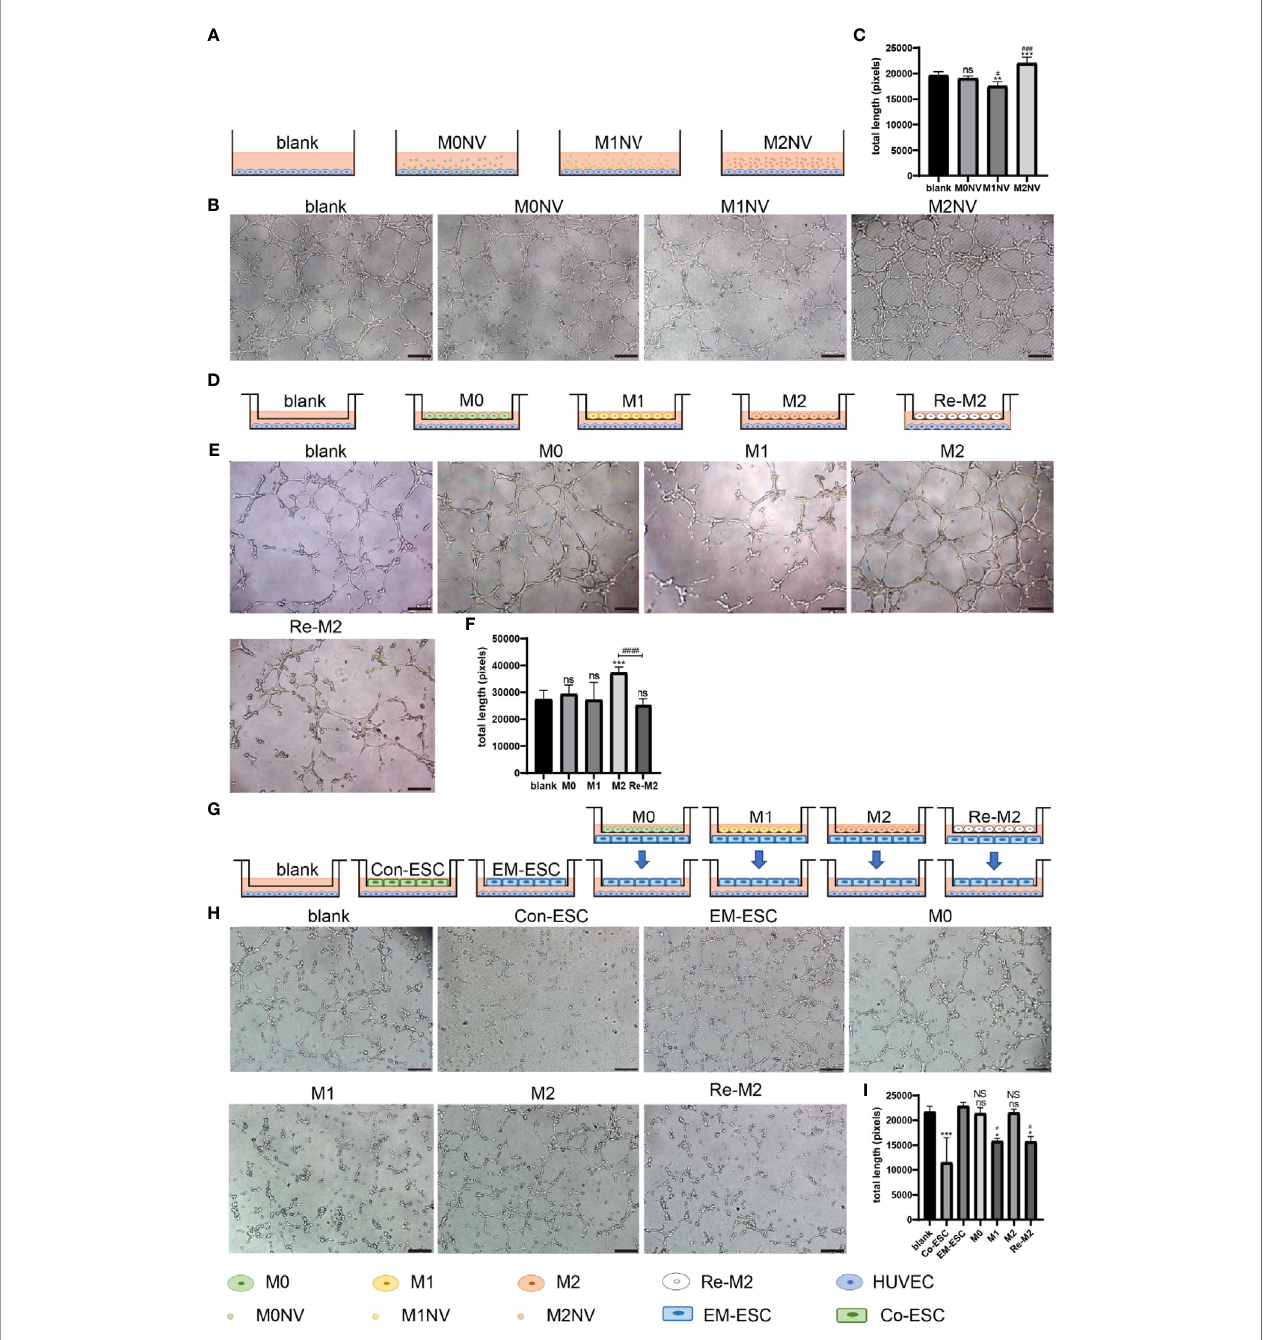
FIGURE 4 | M1NVs could inhibit HUVEC tube formation in vitro in direct and indirect way. (A, D, G) Co-culture pattern diagram of HUVEC tube formation. (B, C) Tube formation of HUVECs treated with NVs directly (Scale bar =100 m m). (ns: no signi fi cance when compared with blank. **P<0.01, ***P<0.001 when compared with blank. # P<0.05, ### P<0.001 when compared with M0NVs). (E, F) Tube formation of HUVECs treated with different types of macrophages (Scale bar =100 m m). (ns: no signi fi cance when compared with blank. ***P<0.001 when compared with blank. #### P<0.0001 when compared with M2). (H, I) Tube formation of HUVECs treated with ESCs which were cocultured with different types of macrophages (Scale bar = 100 m m). (*P<0.05, ***P<0.001 when compared with blank. ns, No signi fi cance when compared with Co-ESCs. NS, No signi fi cance when compared with EM-ESCs. # P<0.05 when compared with